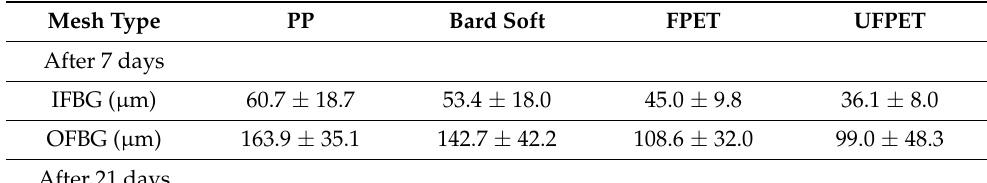
Table 3. Average inner and outer granuloma sizes with the standard deviation, as measured with hematoxylin/eosin